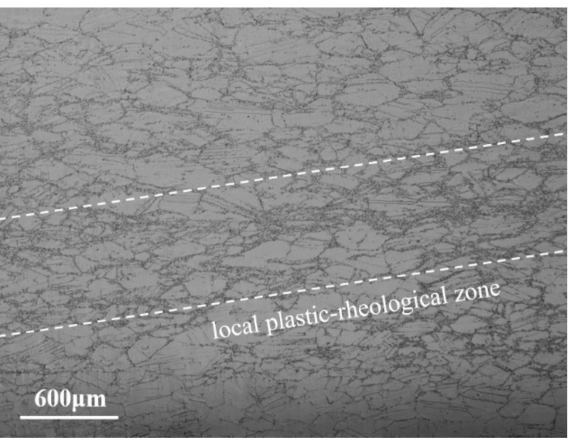
Figure 9. Microstructures of Inconel 625 under in the unstable